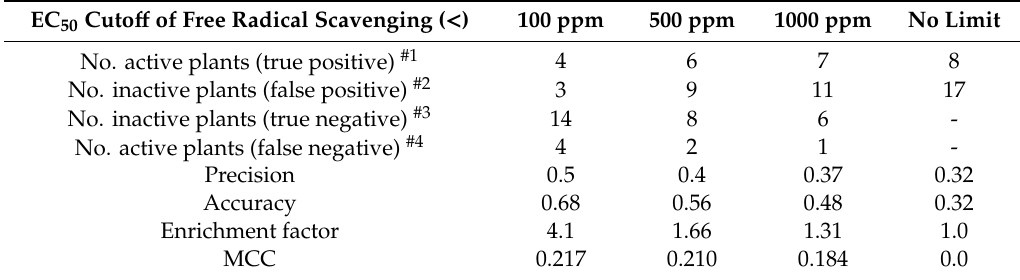
Table 2. Matthew’s correlation coe ffi cient (MCC) scores, precision, accuracy, and enrichment factors as criteria for evaluating the prediction models. EC 50 Cuto ff of Free Radical Scavenging ( <